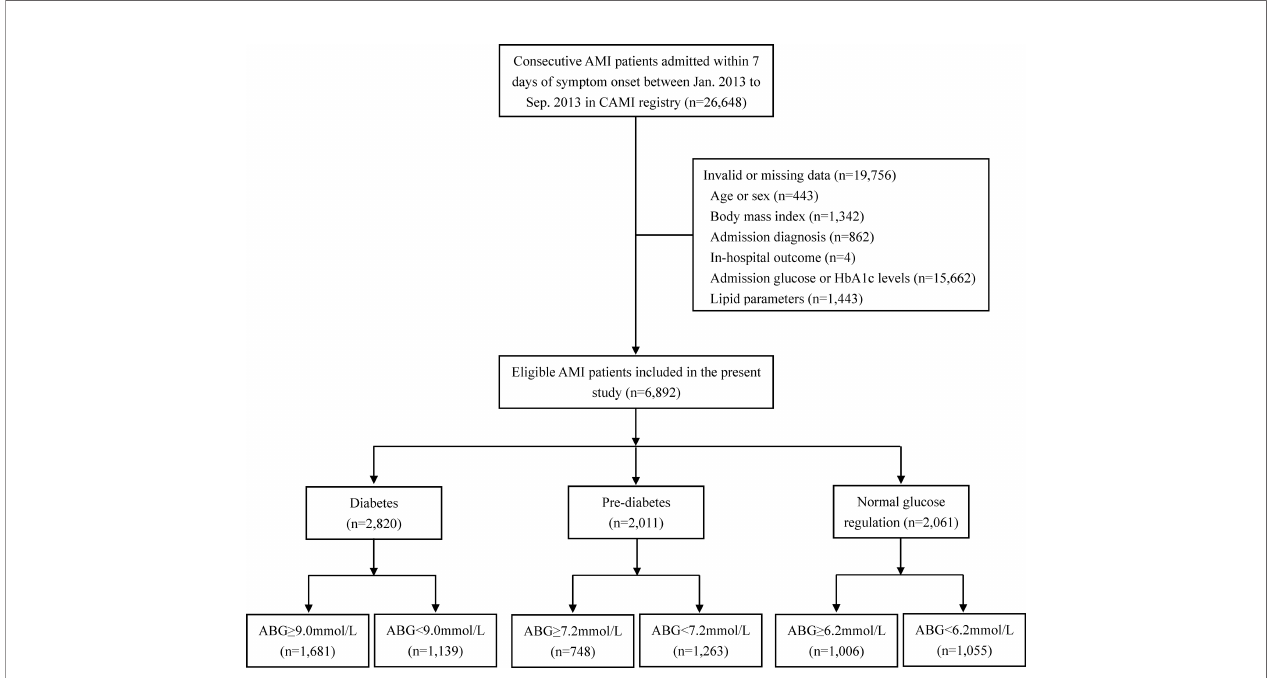
FIGURE 1 | Flow chart of the study. ABG, admission blood glucose; AMI, acute myocardial infarction; CAMI, China Acute Myocardial